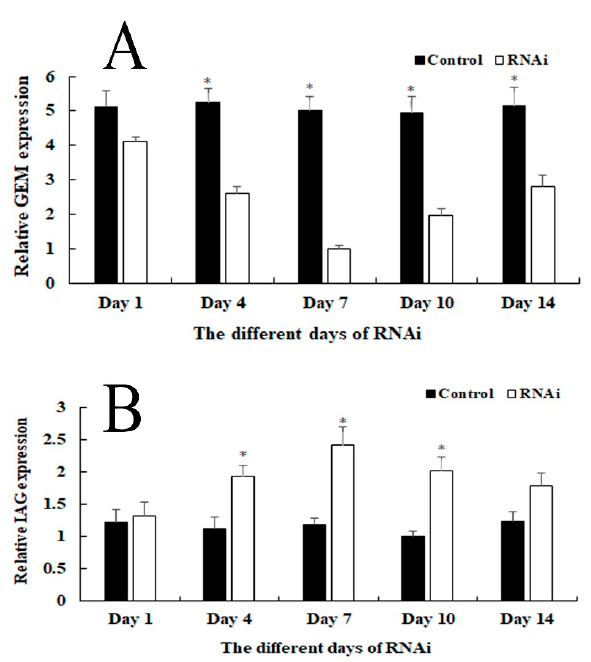
Figure 7. Expression characterization of Mn-GEM and Mn-IAG at di ff erent days after Mn-GEM dsRNA injection. The amount of Mn-GEM and Mn-IAG mRNA was normalized to the EIF transcript level. Data are shown as mean + SD (standard deviation) of tissues from three separate individuals. * indicates significant expression di ff erence between the RNAi group and control group at the sample day. ( A ) Expression characterization of Mn-GEM after Mn-GEM dsRNA injection. ( B ) Expression characterization of Mn-IAG after Mn-GEM dsRNA injection.